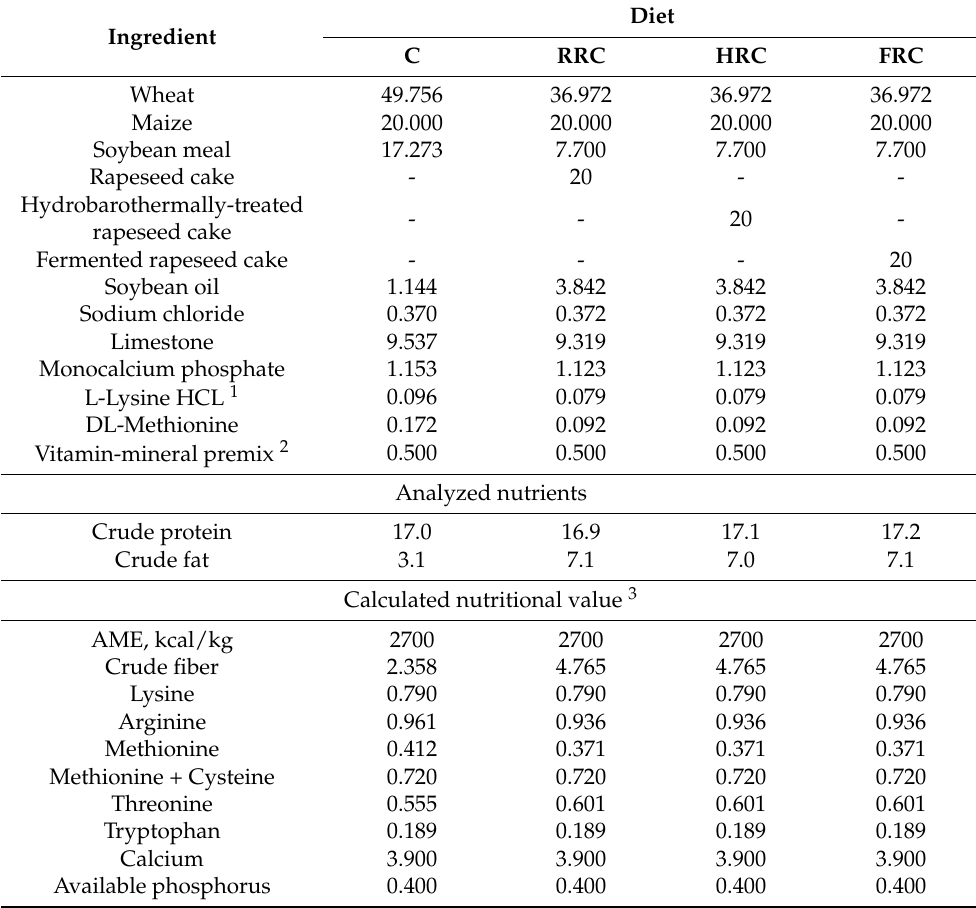
Table 1. Ingredient composition and nutritional value of experimental diets